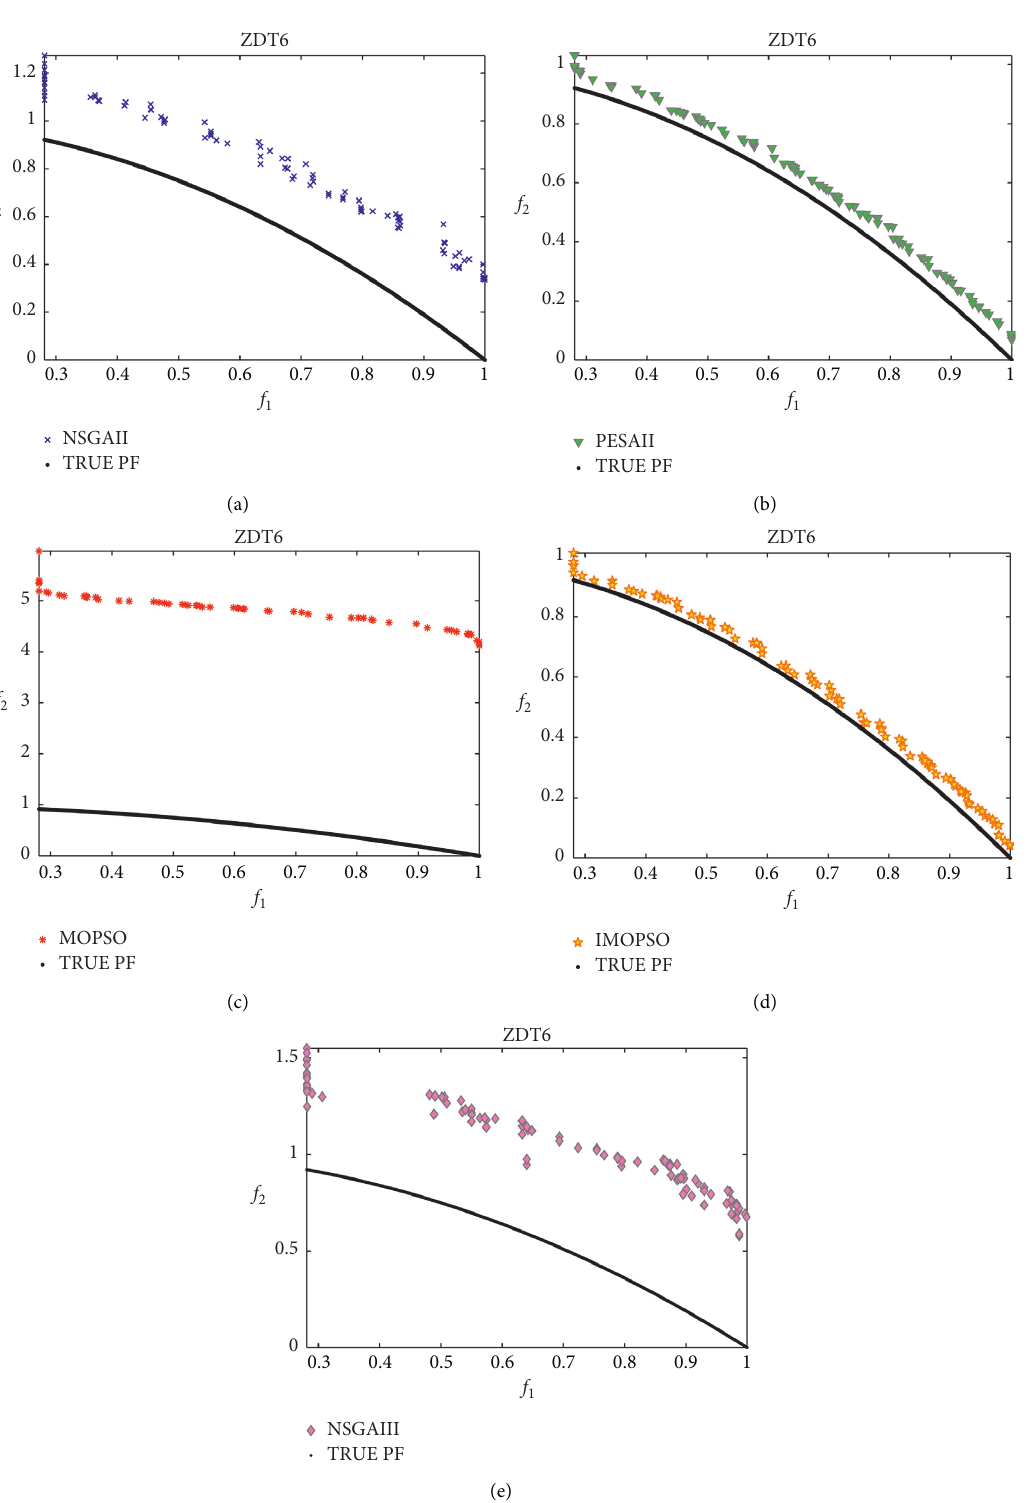
Figure 6: ZDT6 test